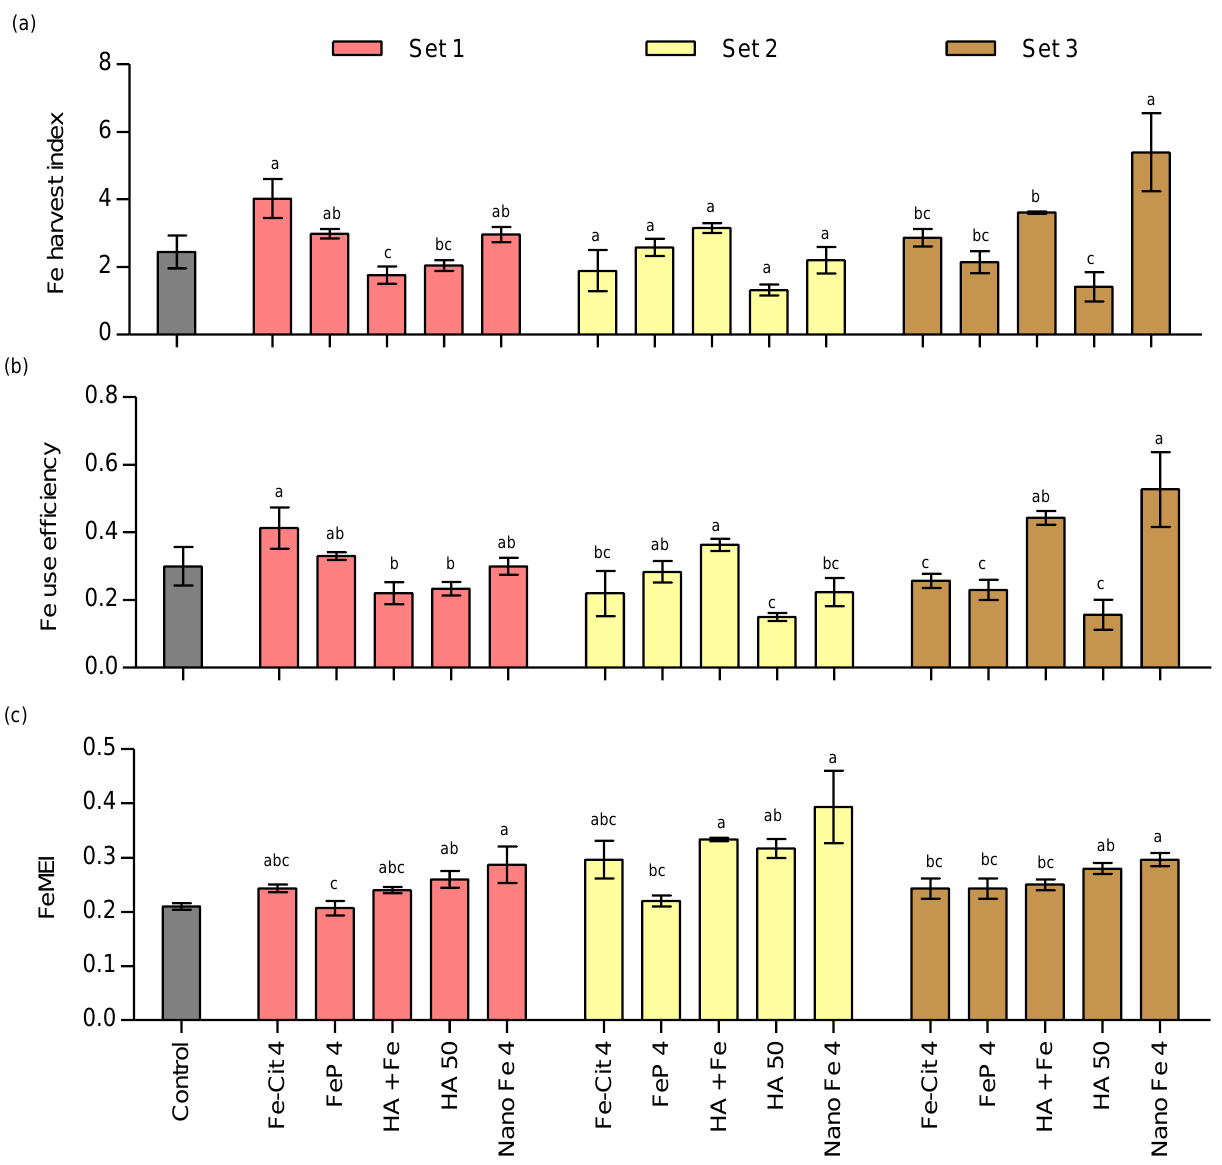
Figure 9. Influence of foliar application of Fe compounds on Fe indices in soybean: ( a ) Fe harvest index, ( b ) Fe use efficiency, and ( c ) Fe mobilization efficiency index (FeMEI). Data correspond to means ± SEm ( n = 5). The plants of set 1 and set 2 received single sprays in the flowering and pod-filling stages, respectively, while set 3 plants were sprayed in both growth stages. Each set was analyzed separately using a one-way ANOVA, and the least significant difference was calculated. Means with same letter were not significantly different at p < 0.05. Details of the two-way ANOVA are presented in Table S2.